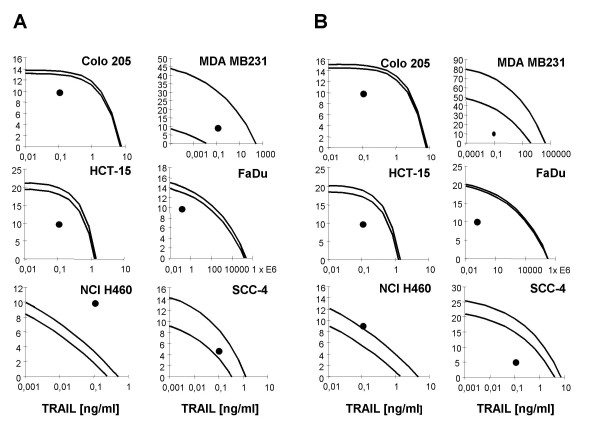
Isobolographic analysis of apoptosis induction after combined treatment. Apoptosis was determined by microscopic evaluation of Hoechst stained cell nuclei 48 h after combined treatment. Envelopes of additivity were calculated with data of 3 independently performed experiments. Datapoints below the curves resemble a synergistic effect, datapoints between the curves demonstrate an additive effect and above the curves a subadditive response of combined treatment. A : tumour cells were treated simultaneously with 10 Gy and 0,1 ng/ml TRAIL. B: cells were irradiated with 10 Gy 12 h prior to treatment with 0,1 ng/ml TRAIL.